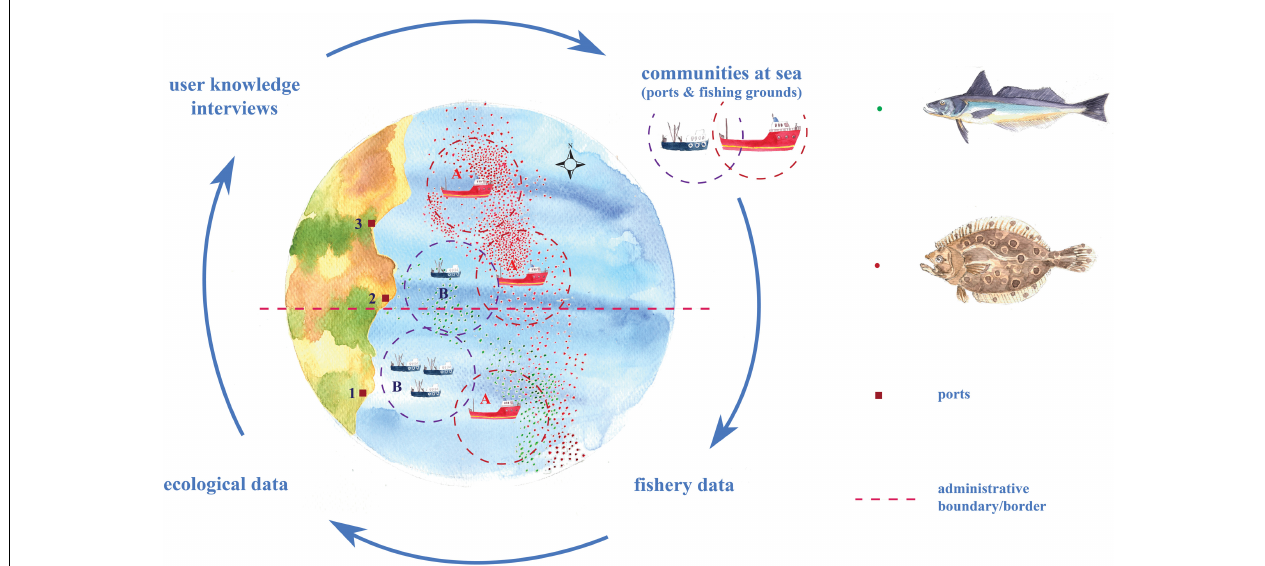
FIGURE 1 | Schematic illustration of the innovative mixed methodological approach used in the framework of research. Response scenarios of fishing communities to species’ distribution shifts depend on port locations (squares), administrative boundaries/borders (dashed line - e.g., different countries or states), and at-sea practices (where: point symbols are trip locations and dashed circles are outlines of fishing grounds). A highly mobile, large vessel community (Community A) has the capacity to follow shifts in species’ distribution from Port 1 to Port 3 offshore locations. A smaller-size vessel community (Community B) may not be able to follow a shift due to vessel-size constraints. Meanwhile, the shift may benefit both large and small communities fishing in Port 2 offshore locations.